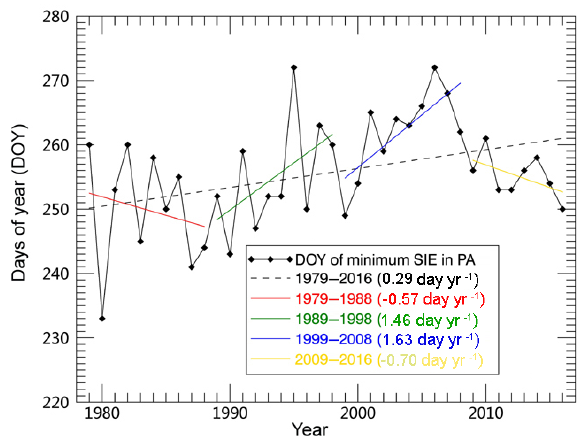
Figure 12. Day of year (DOY) of the annual minimum sea ice area in PA. Table 3. Correlations between summer mean atmospheric index and total sea ice area loss, and sea ice area decline due to melting and advection processes over the period